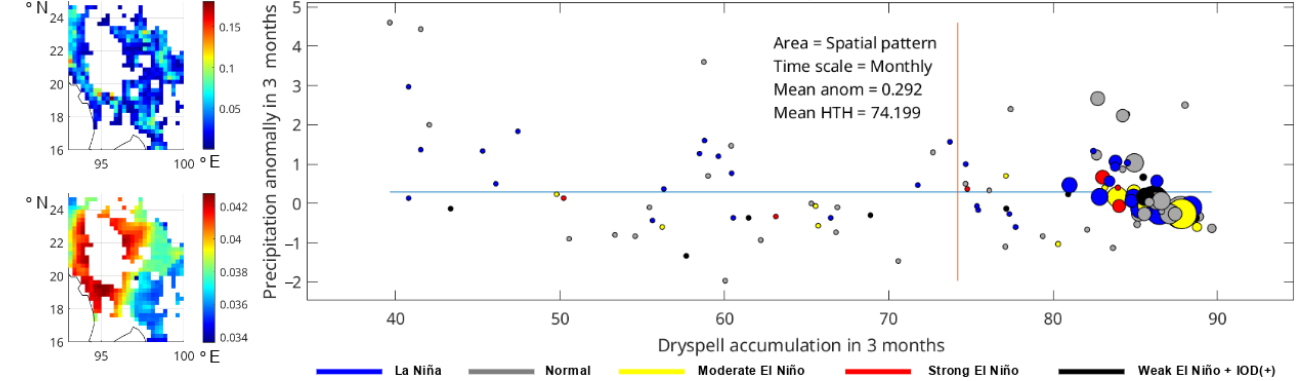
Figure 3. Myanmar—spatial graph of hotspots ( top ) and dry spells ( bottom ) as well as bubble plot of the monthly fire events for all categories. Blue and orange lines represent average value of respective variables. Size of the bubble represents the number of hotspots for each particular month. Extracted from first mode of SVD with 98% of SCF value. Table 1. Myanmar—difference value of the PDF from years categories.